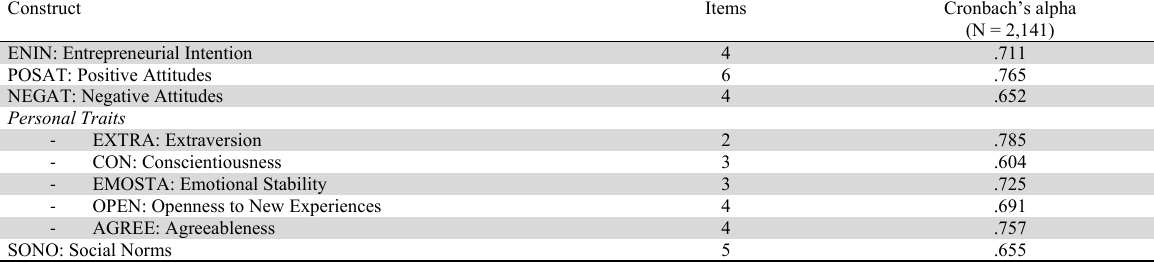
Summary dependent variables and independent variables, reliability